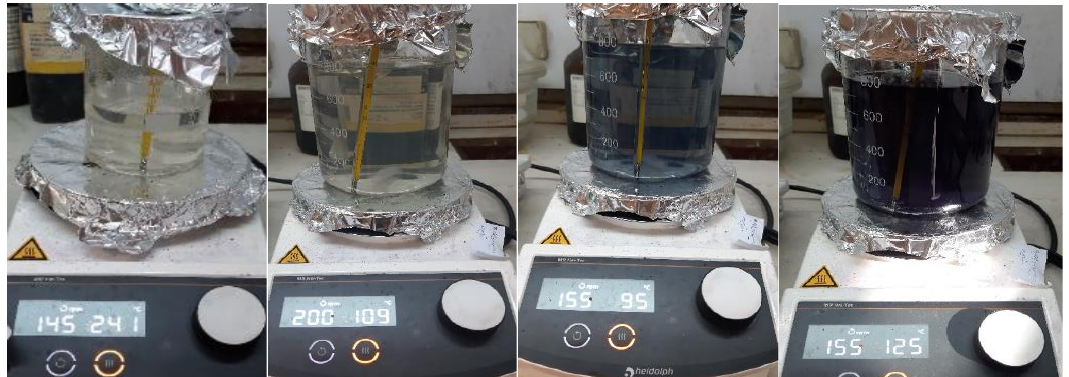
Fig. 2. GENIPIN color changing from pale blue to dark blue (left to right) during Figure 2 : GENIPIN color changing from pale blue to dark blue (left to right) during preparation